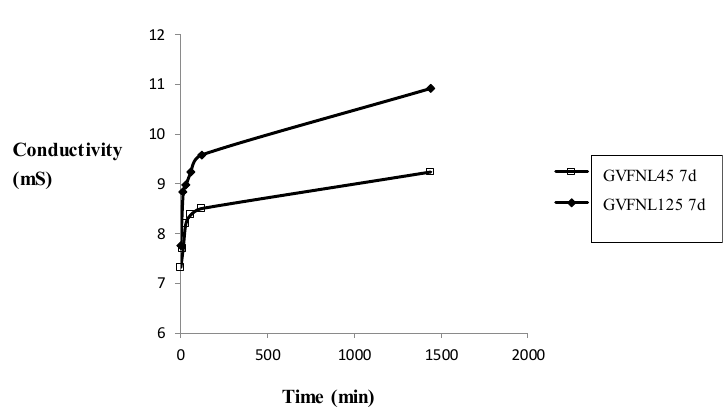
Figure 3. Conductivity trend of geopolymers containing VFNL <45 µ m and <125 µ m as a function of time for a curing time of 7 days.